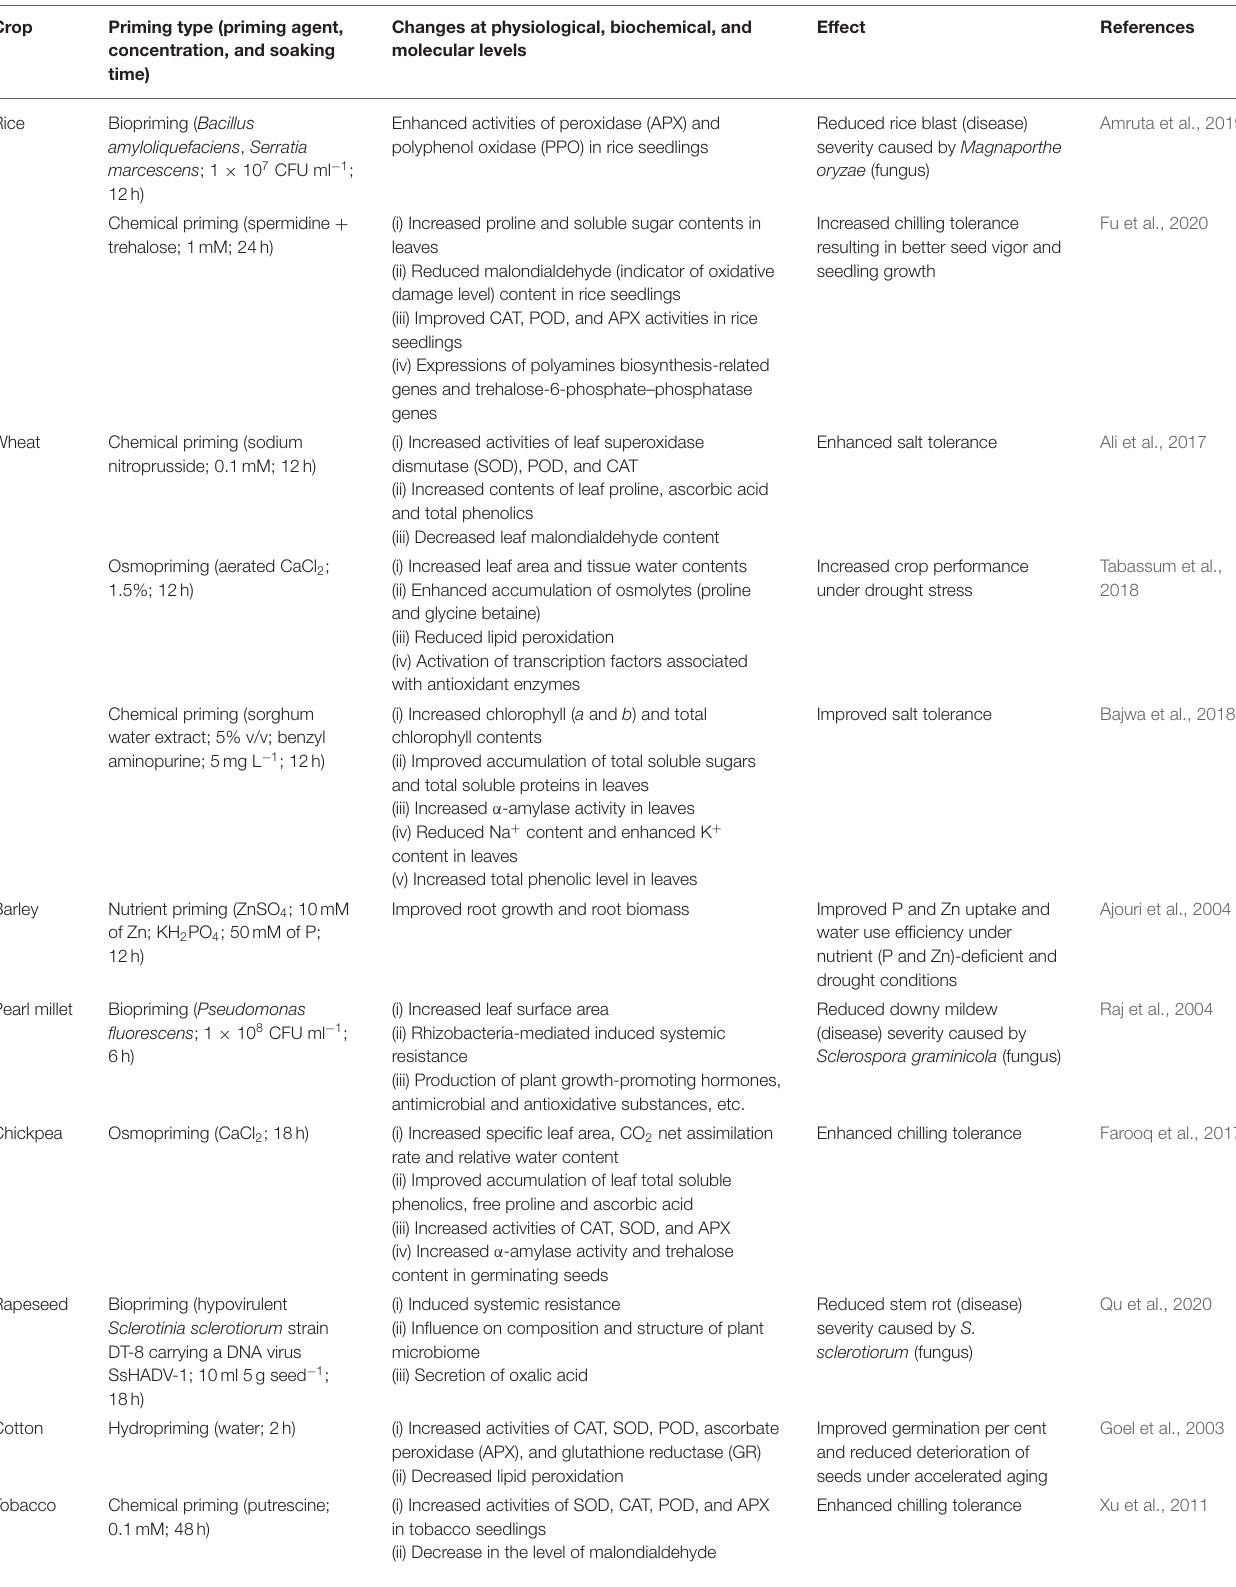
TABLE 1 | Mechanisms of seed priming involved in improved stress tolerance in crops. Crop Priming type (priming agent, concentration, and